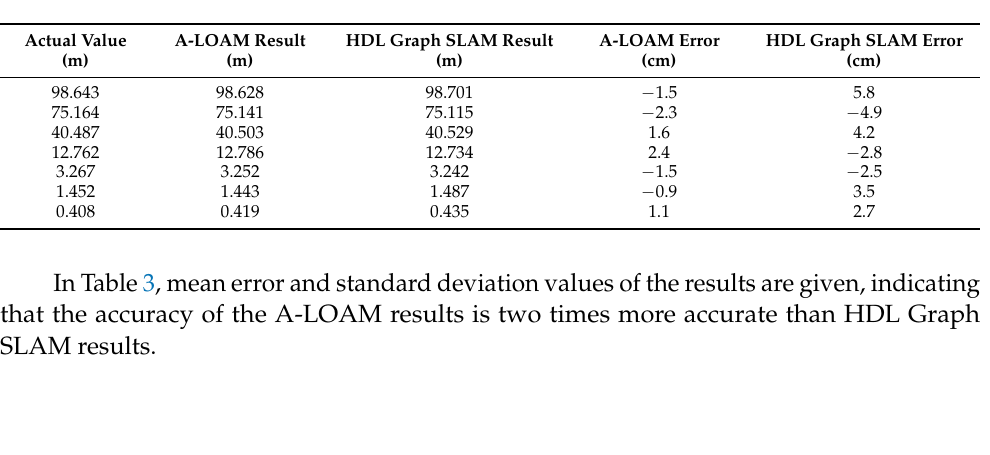
Table 2. Differences between the actual values and the SLAM Results for an outdoor